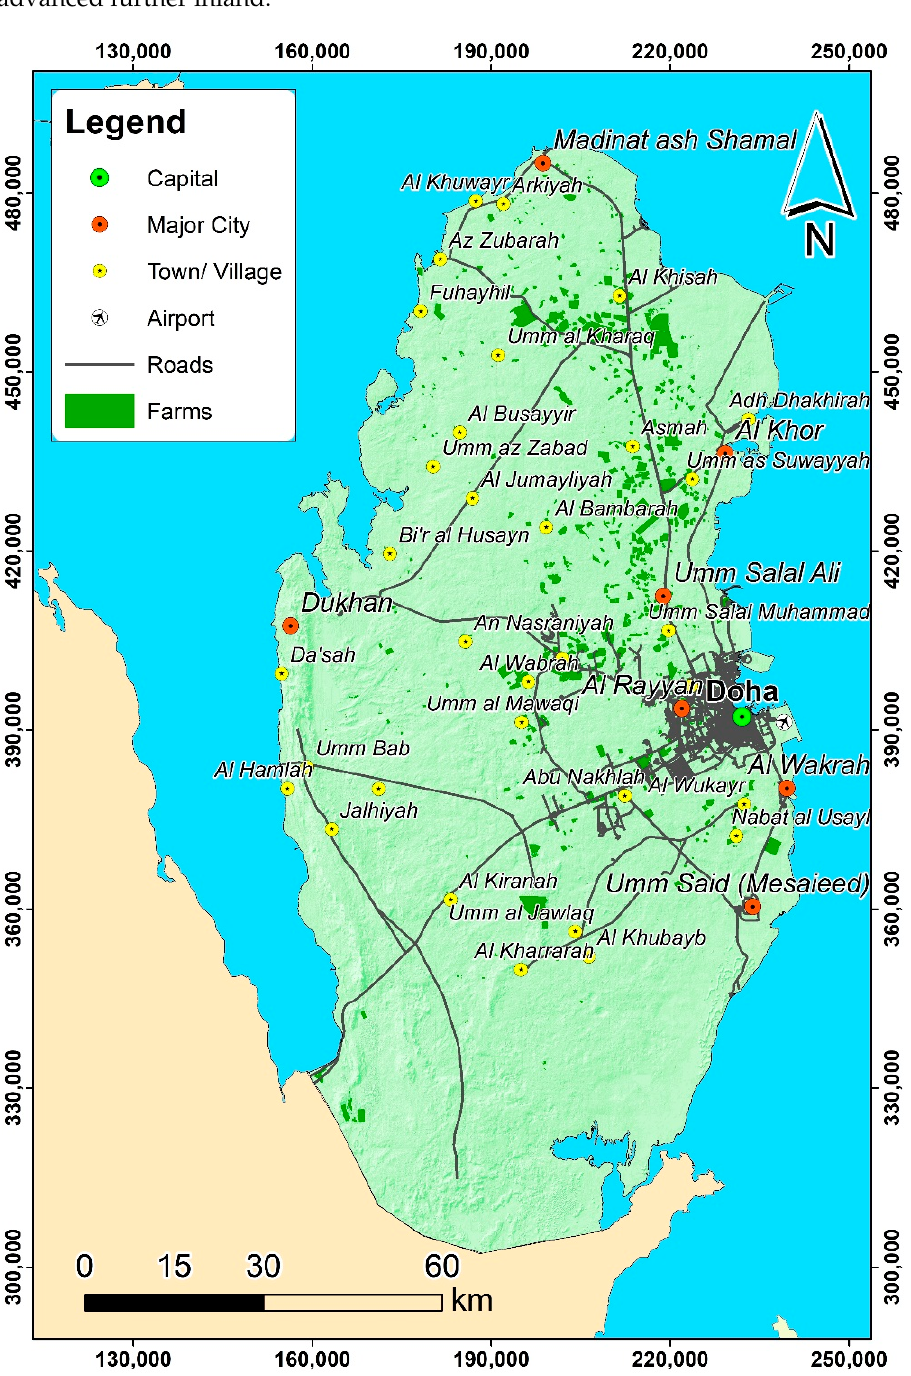
Figure 1. The study area.